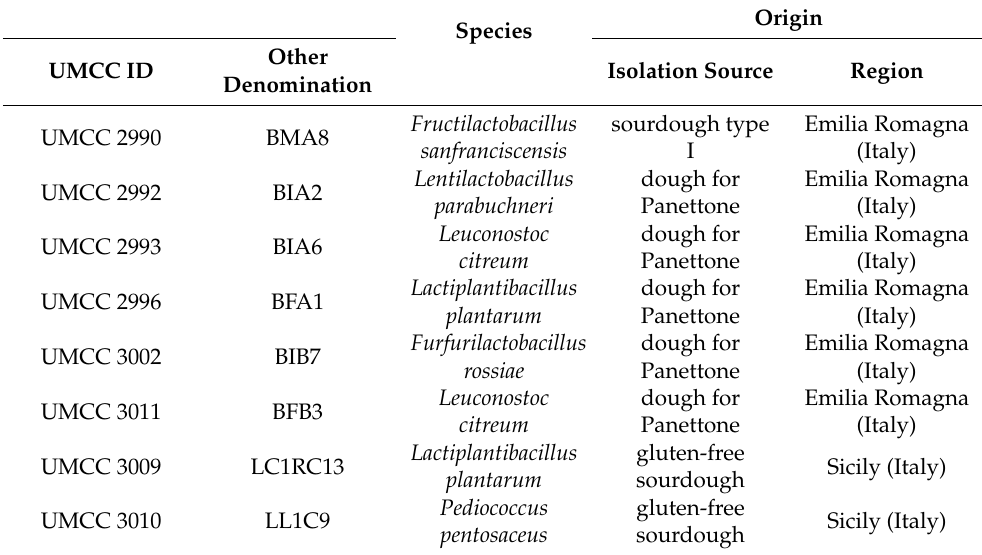
Table 1. Lactic acid bacteria strains from Unimore Microbial Culture Collection (UMCC) tested in the present